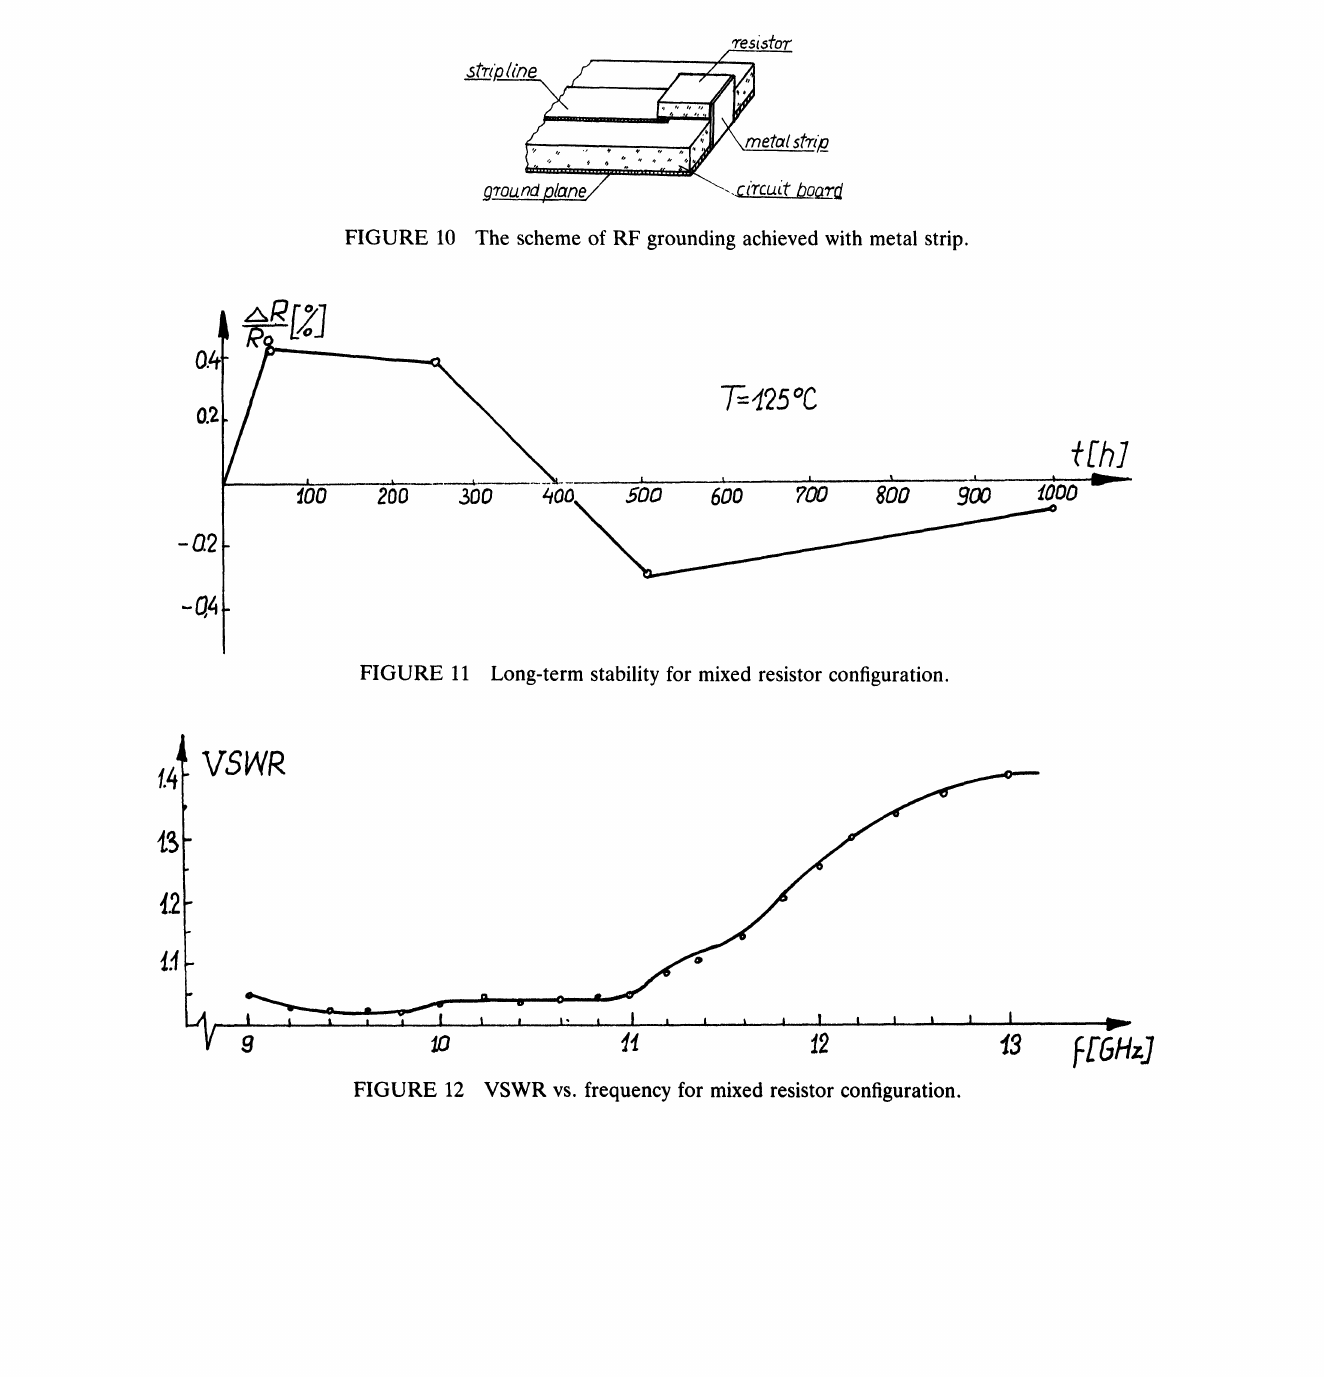
FIGURE 10 The scheme of RF grounding achieved with metal strip.